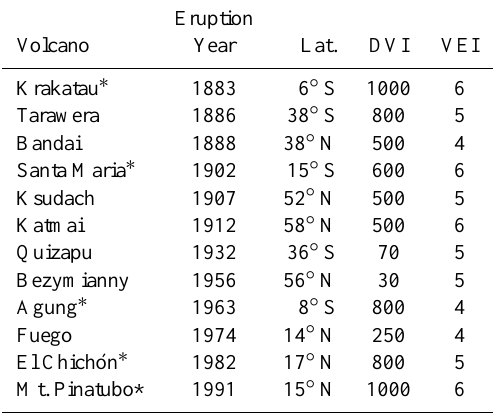
Table 1. Years of selected volcanic eruptions modified from Robock and Mao (1992). DVI denotes “Dust Veil Index”, and VEI denotes “Volcanic Explosivity